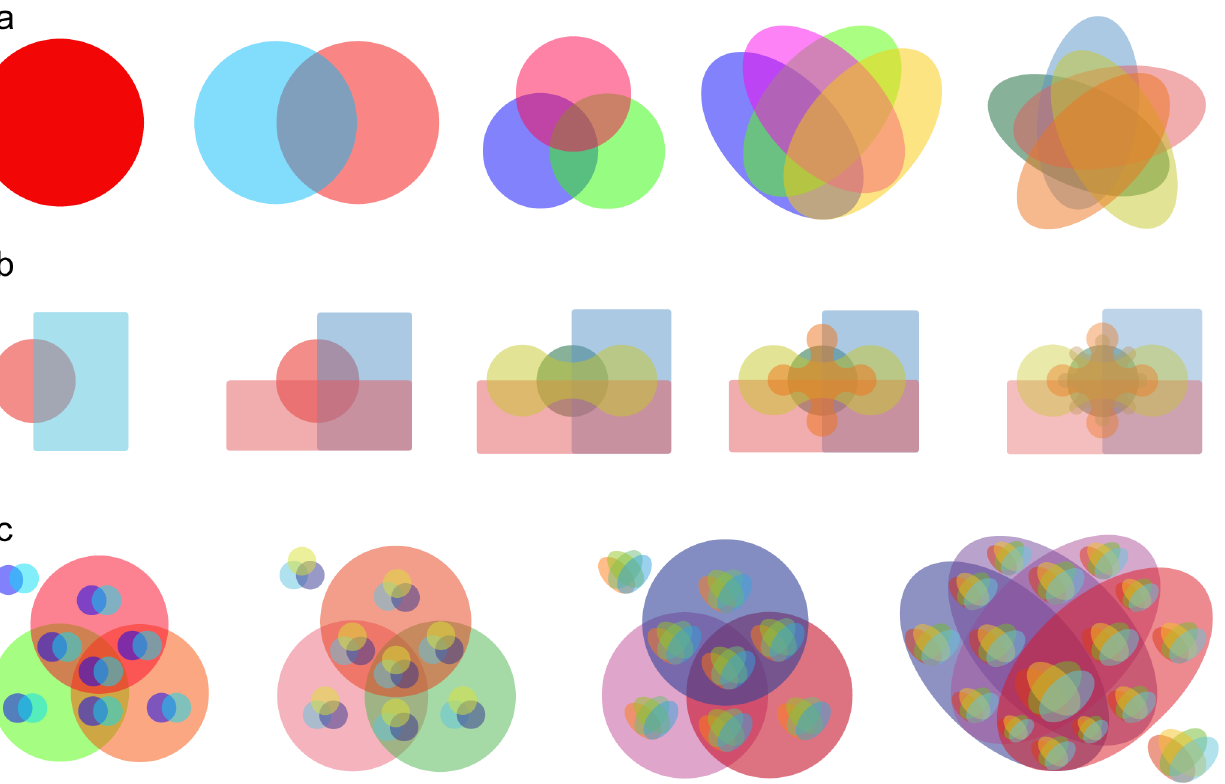
Fig 4. Venn diagrams and Nested Venn in VennPainter. (a) Classic Venn diagram depicting from one to five datasets. (b) Edwards ’ Venn diagrams for from two to six datasets. (c) Nested Venn diagrams showing from five to eight variables. Nested Venn diagrams uses single-level Classic Venn diagrams to construct multi-level ones, which are easier to interpret than other forms of Venn diagrams when the datasets reaches more than